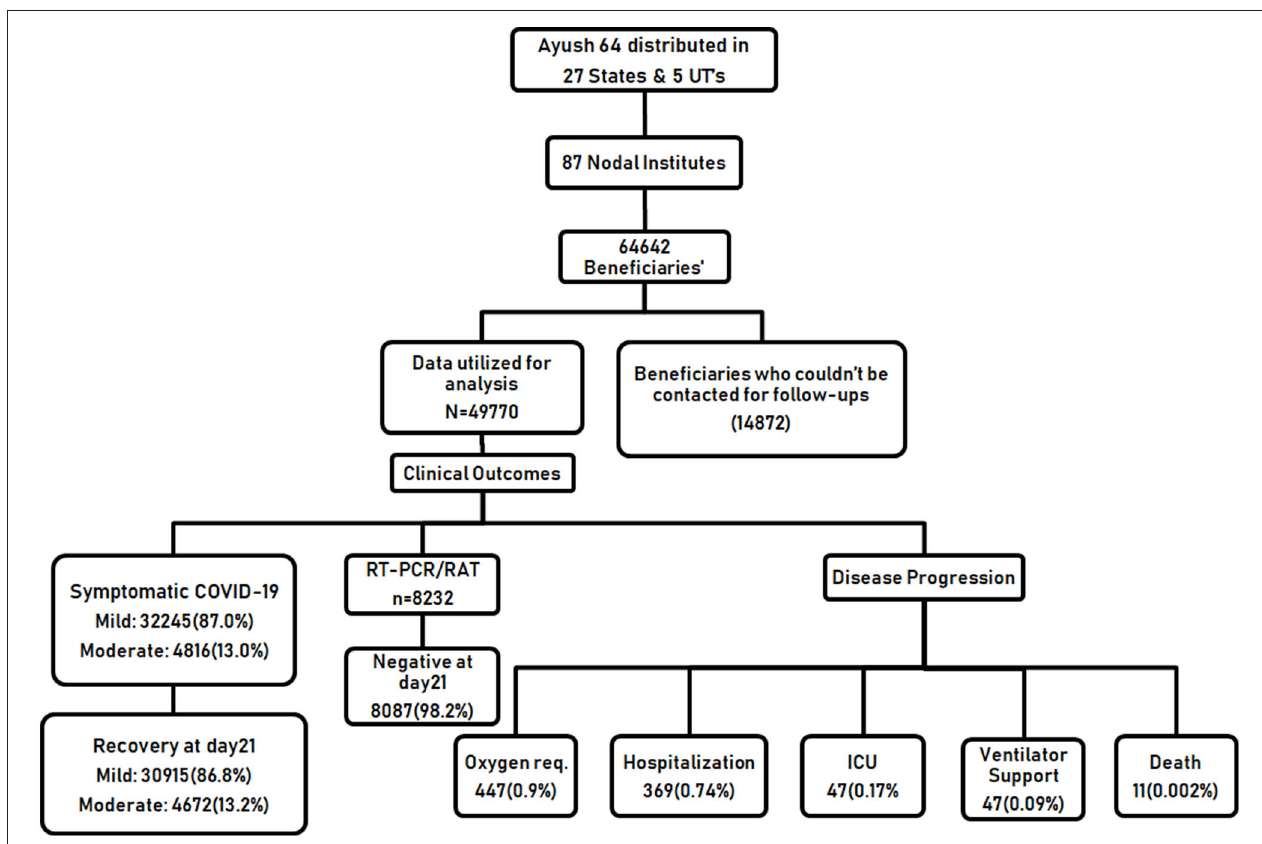
FIGURE 1 | Flow diagram of the